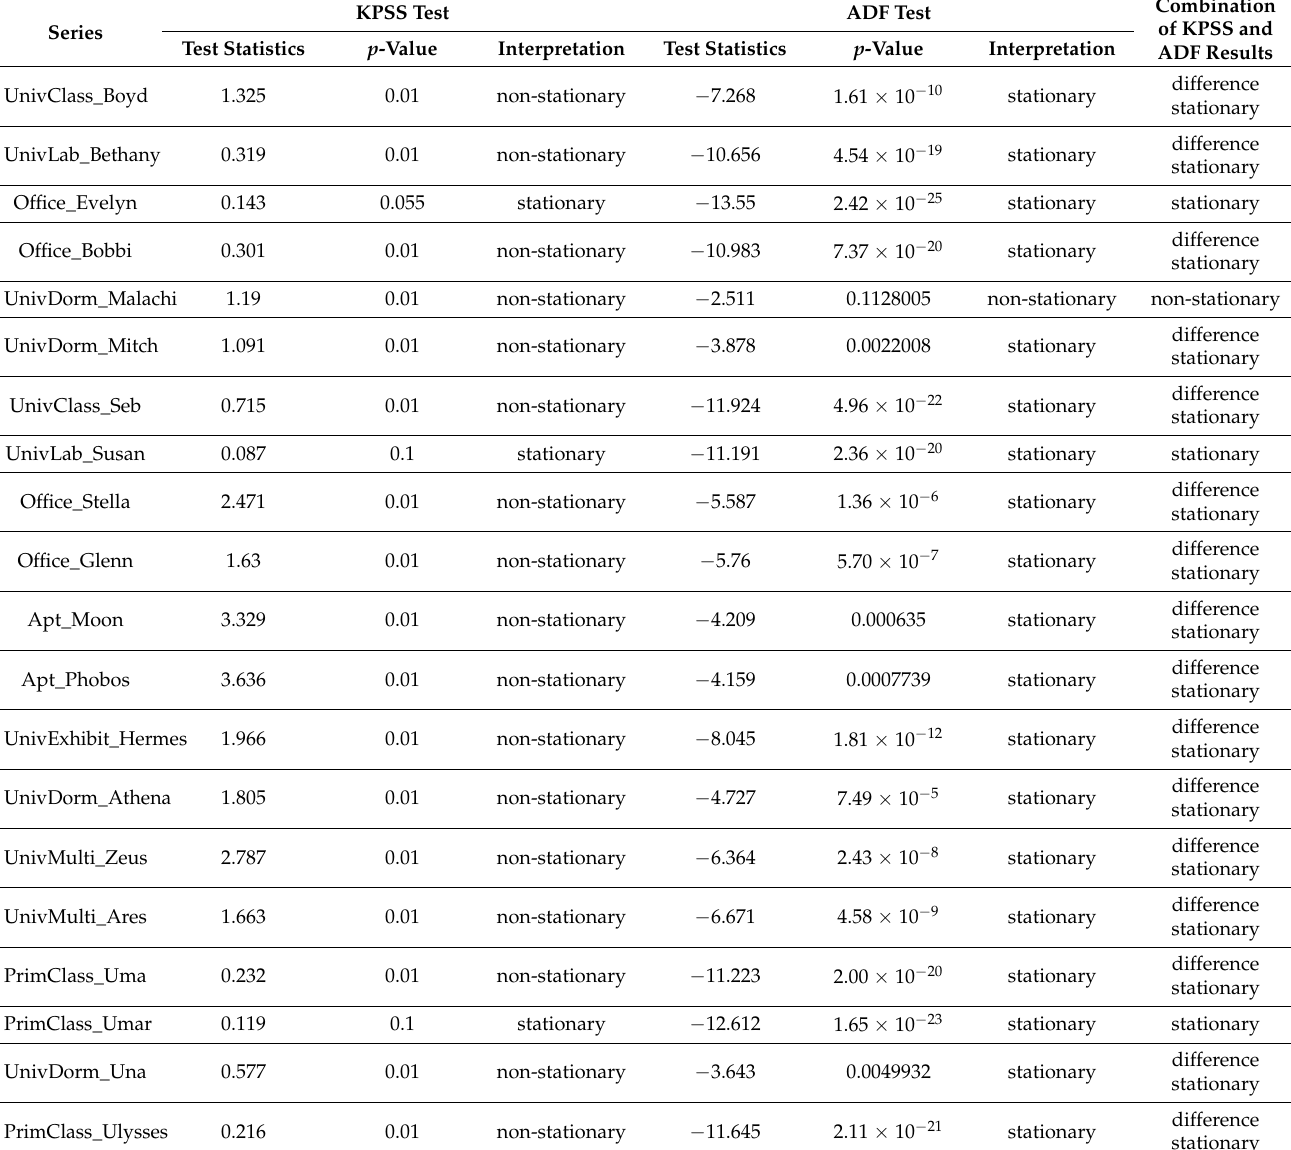
Table 4. Results of KPSS and ADF